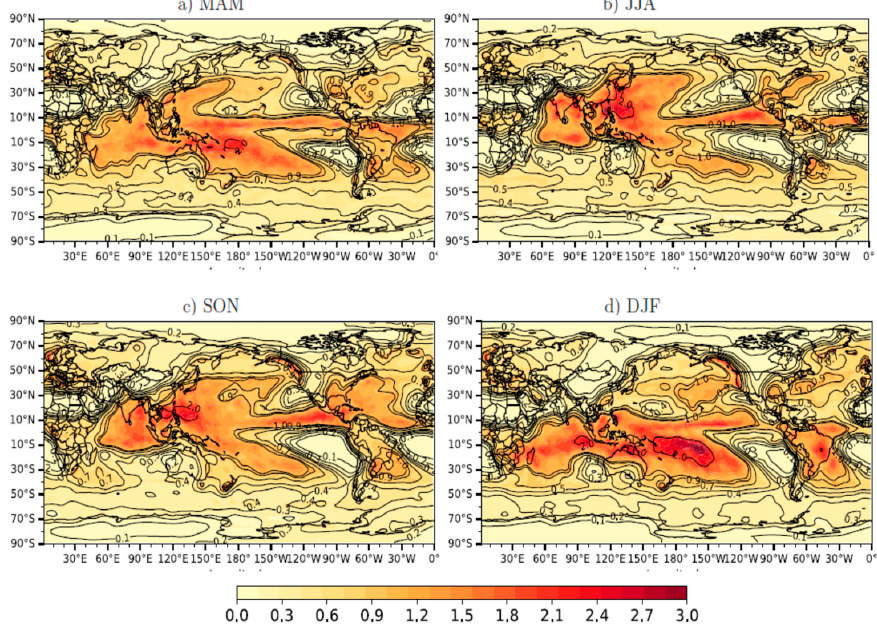
Figure 3. Unpredictable component standard deviation of GPCP precipitation (mm/day).